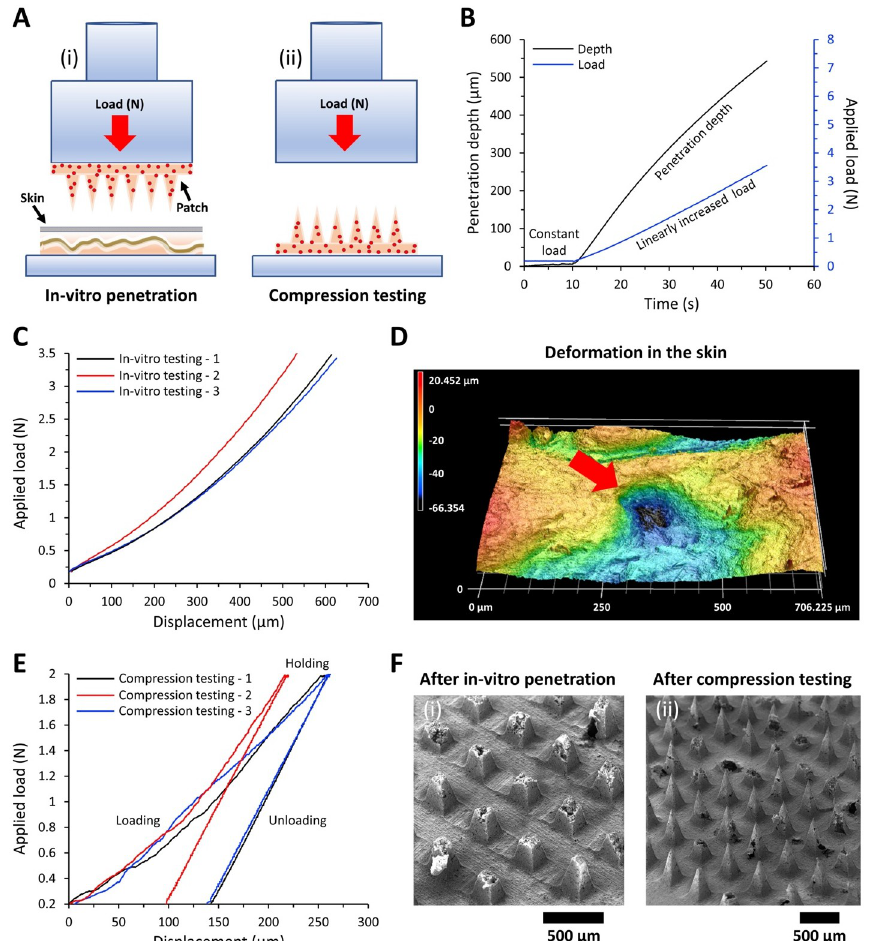
Fig 5. Mechanical property of microneedle patch. A) Schematics of i) in-vitro penetration testing and ii) compression testing set-up, B) applied normal load and measured penetration depth during the in-vitro testing, C) load-displacement relationship obtained from the in-vitro testing (n = three different samples, individually represented in the figure), D) 3D optical topography image of an indent made by one of the microneedles after the microneedle withdrawal, E) the load-displacement relationship obtained from the compression testing (n = three different samples, individually represented in the figure), F) SEM images of the microneedle patch surface after (i) in-vitro penetration and (ii) compression